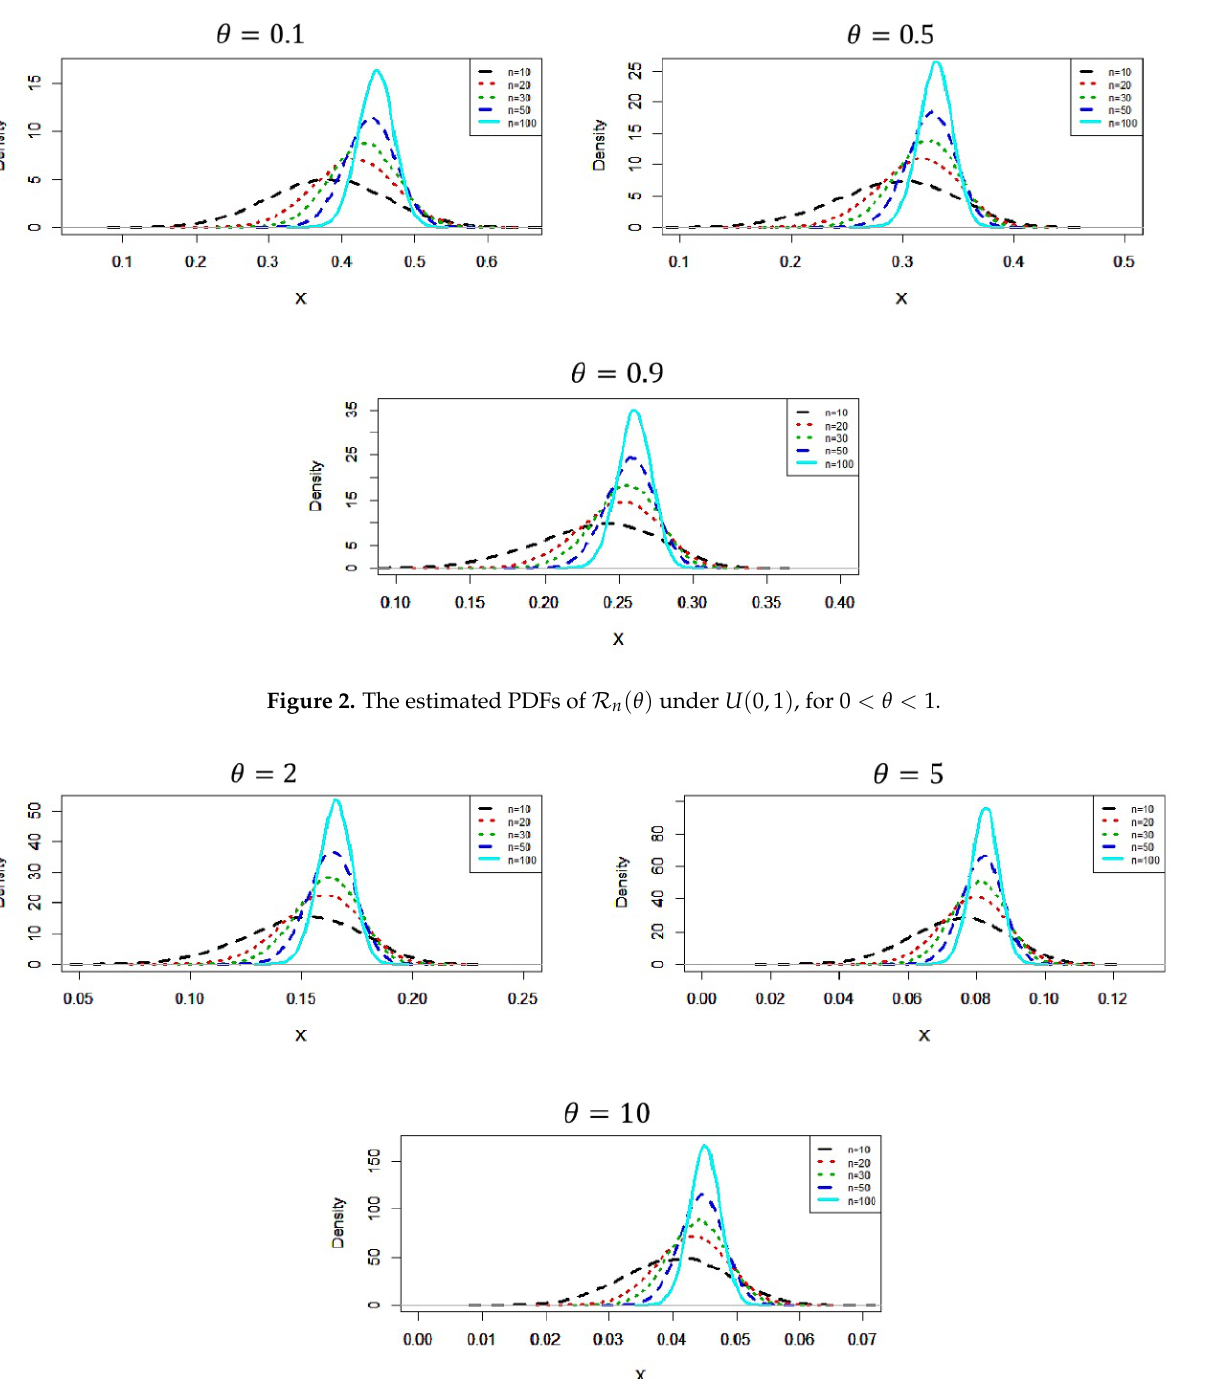
Figure 3. The estimated PDFs of R n ( θ ) under U ( 0,1 ) , for θ >